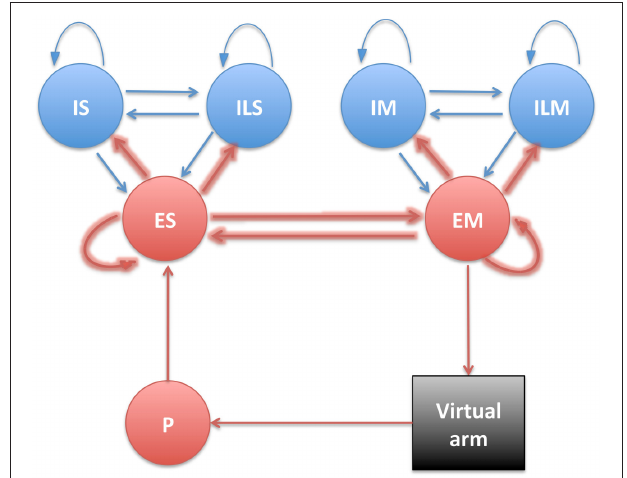
FIGURE 2 | Diagram showing the different neural populations with arrows indicating connections (plastic connections are shown as thicker